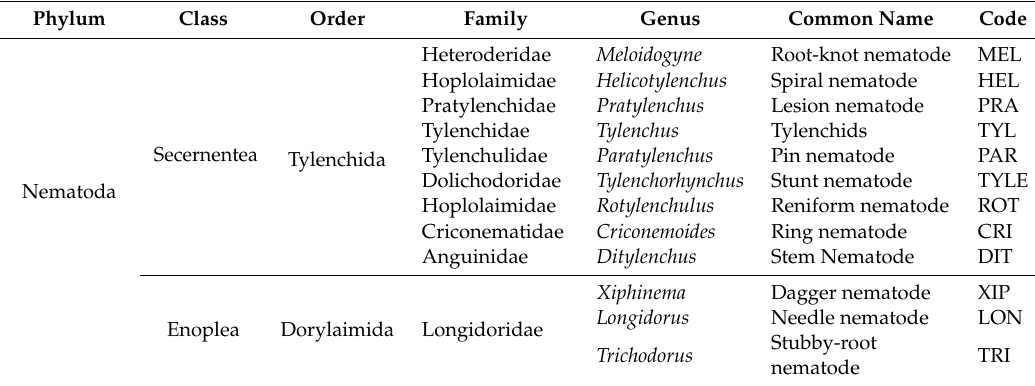
Table 1. Grouping of plant parasitic nematode genera found on organic fields in Southern Morocco (survey January